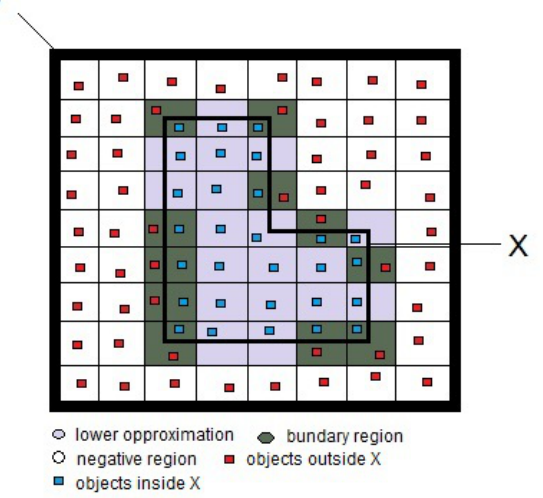
Fig. 1 . Schematic overview of